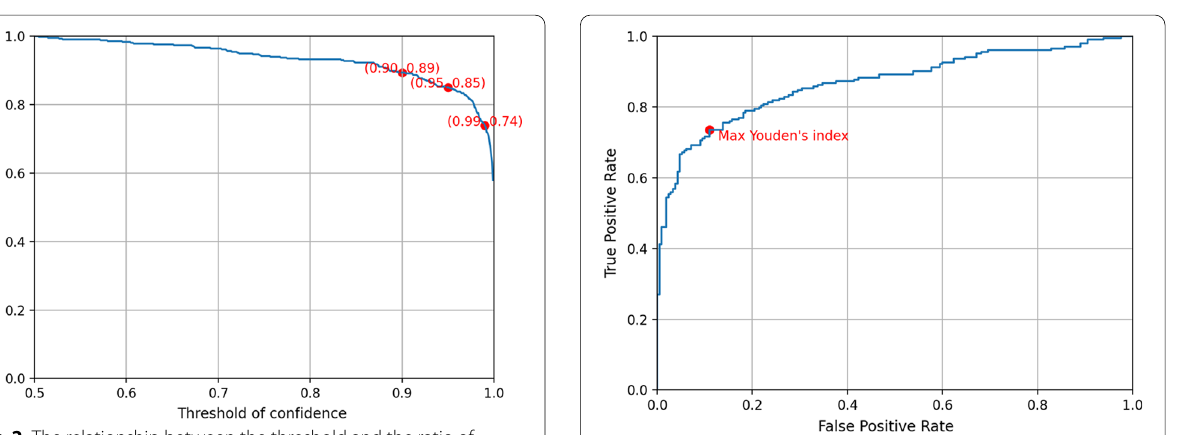
Fig. 3 The side-based ROC curve of the AI diagnosis for axillary LN metastasis on the 414